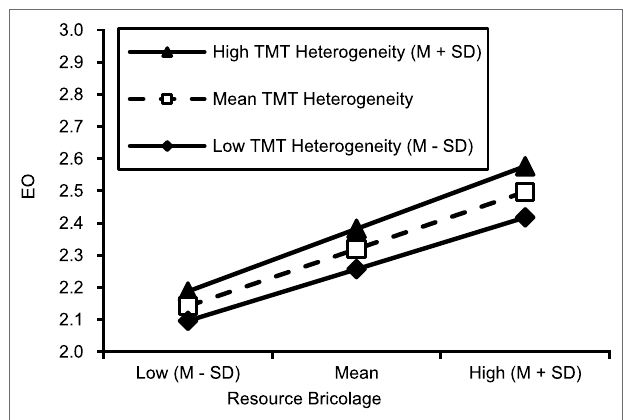
FIGURE 1 | TMT heterogeneity’s moderating effect.